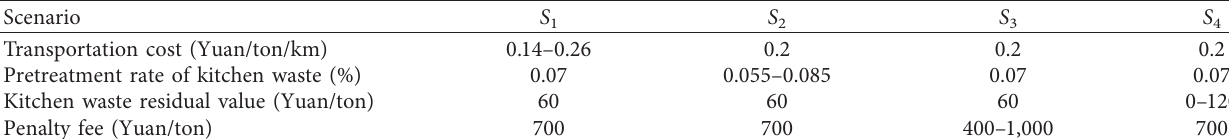
Table 6: Setting of sensitivity analysis.